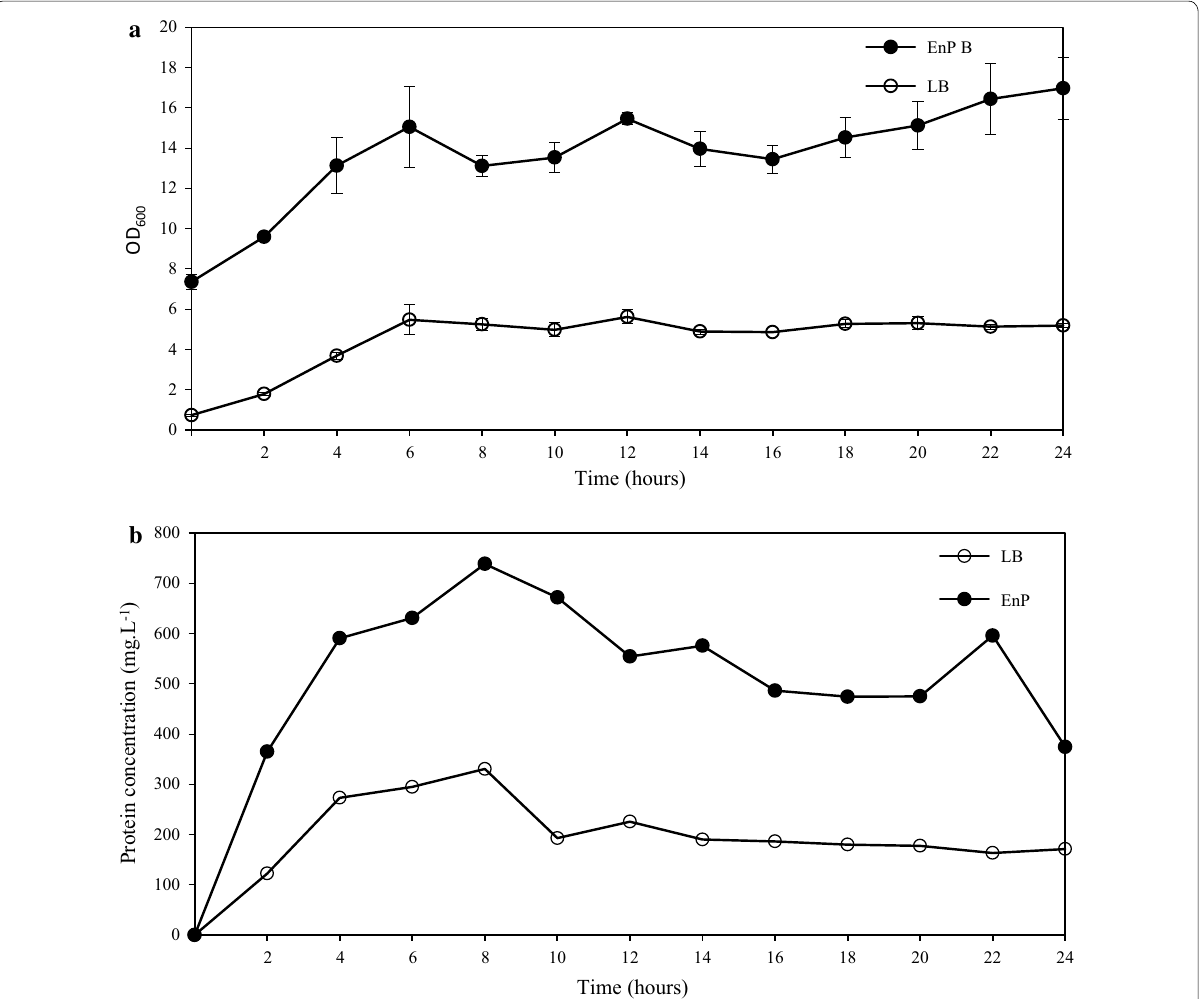
Fig. 2 A graph showing the growth of EC-VP1 in shake flasks measured at OD 600 ( a ) and VP1 protein expressed in EC-VP1 ( b ) in LB and EnPresso B media measured over 24 h post-induction. The OD 600 was measured bi-hourly in triplicate (error bars indicate the standard deviation) and a pooled sample was analyzed for protein concentrations that were produced over 24